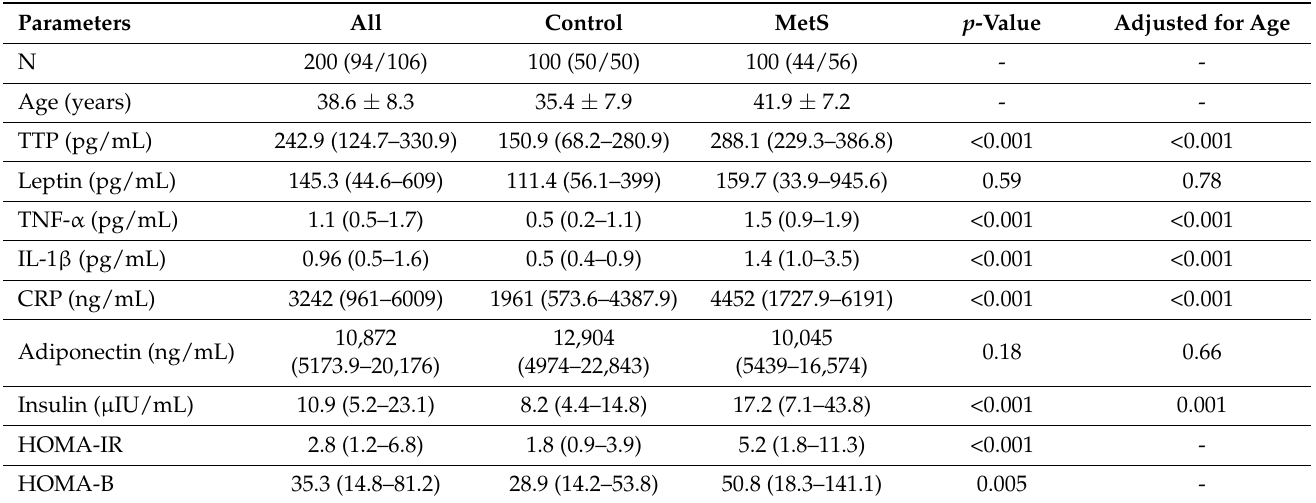
Table 1. Clinical characteristics of the study participants.